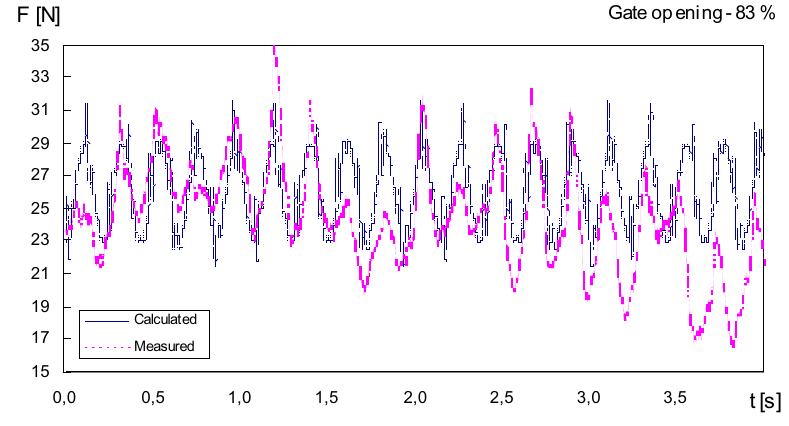
Fig. 11. Calculated and measured force comparison.